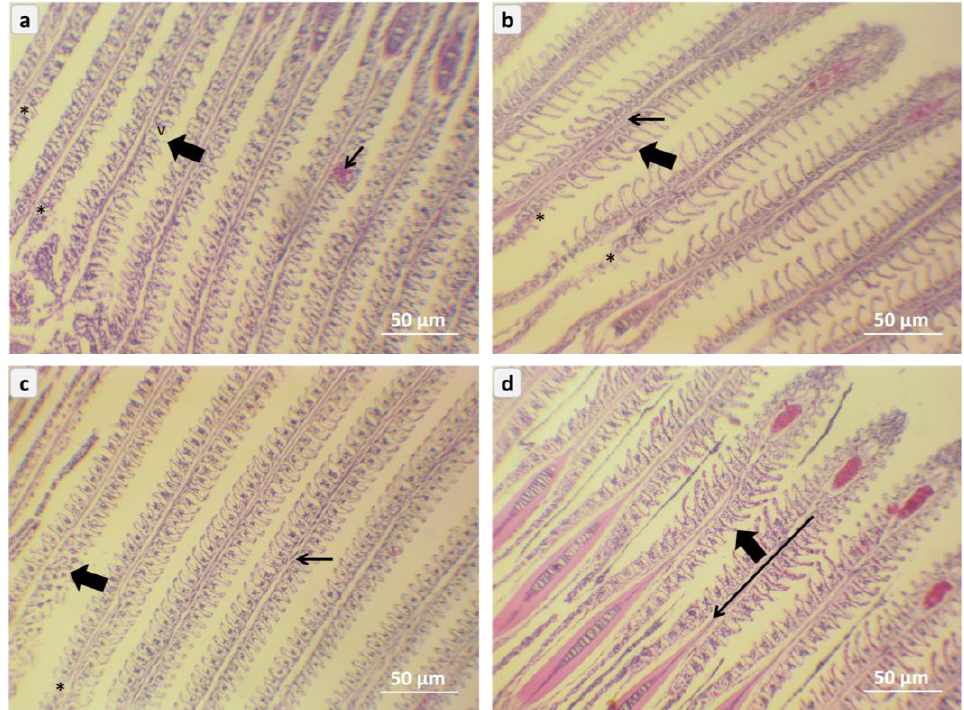
Figure 6. Representative micrograph of gill sections of red tilapia ( Oreochromis sp . ) challenged with Aspergillus flavus , ( a ) → NC0, ( b ) → NC1, ( c ) → NC2, ( d ) → NC3. NC0: control diet; NC1: nanocurcumin 40 mg/kg diet; NC2: nanocurcumin 50 mg/kg diet; NC3: nano curcumin 60 mg/kg diet. Thin arrows = primary lamella, Thick arrows = secondary filaments. (H&E, Bar = 50 µm) V = vacuoles, and Asterisks = deletion of some secondary filaments.